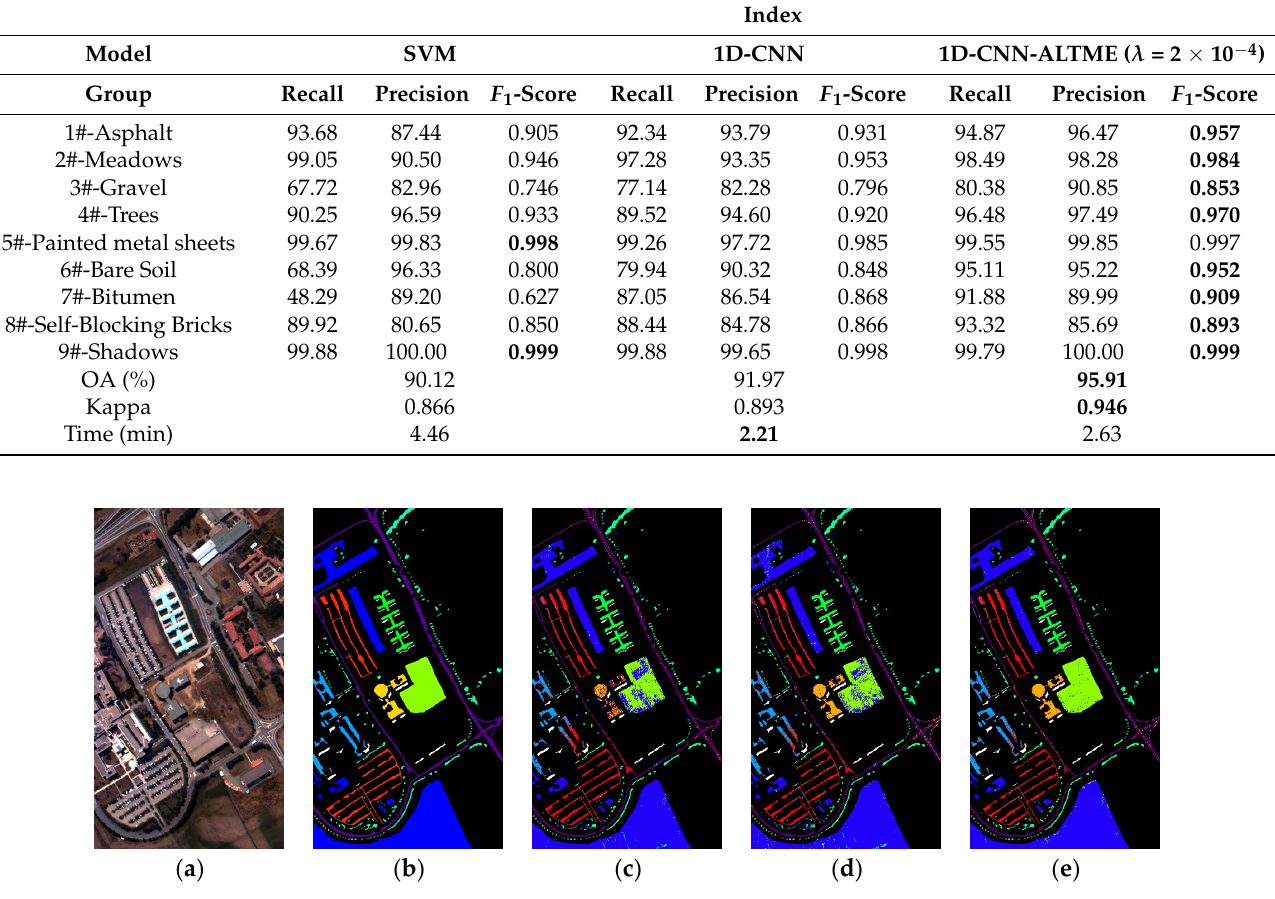
Table 11. Recognition accuracy results for the Pavia University data.